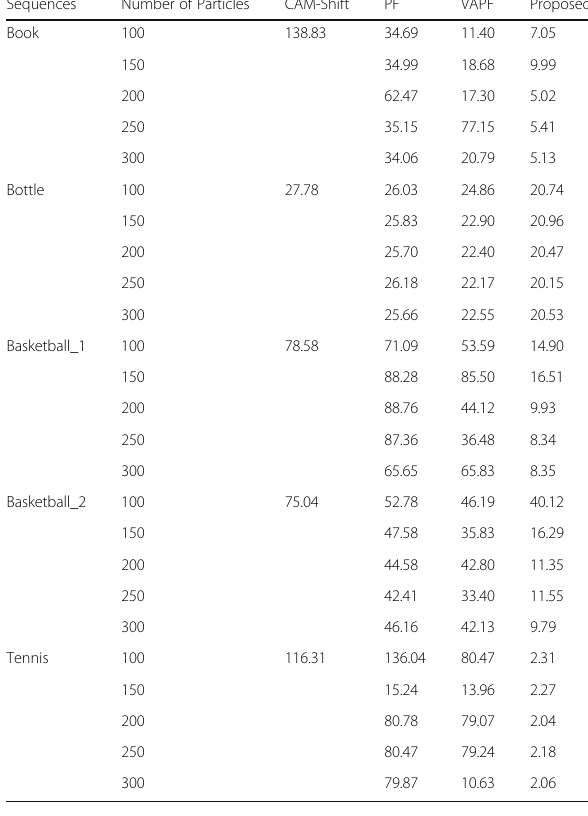
Table 2 Parameter values used in the test Table 1 Resulting of using different particle number